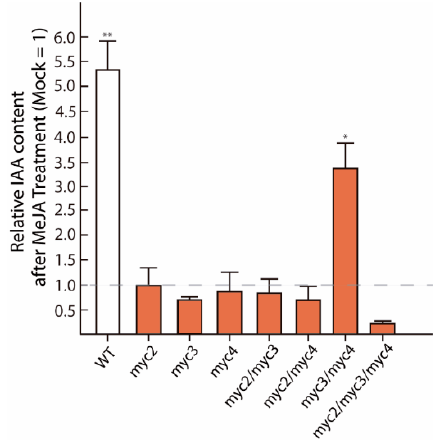
Figure 1. JA-triggered IAA biosynthesis is curtailed in myc mutants. IAA contents were assessed by GC-MS/MS in 10 days-old seedlings treated with either 50 µ M MeJA or a mock solution (0.5% MeOH ( v / v )) for 4 h. Stable isotope labelled [ 2 H 2 ]-IAA was used as internal standard for the absolute quantification of IAA in the samples. To determine the relative IAA-production after